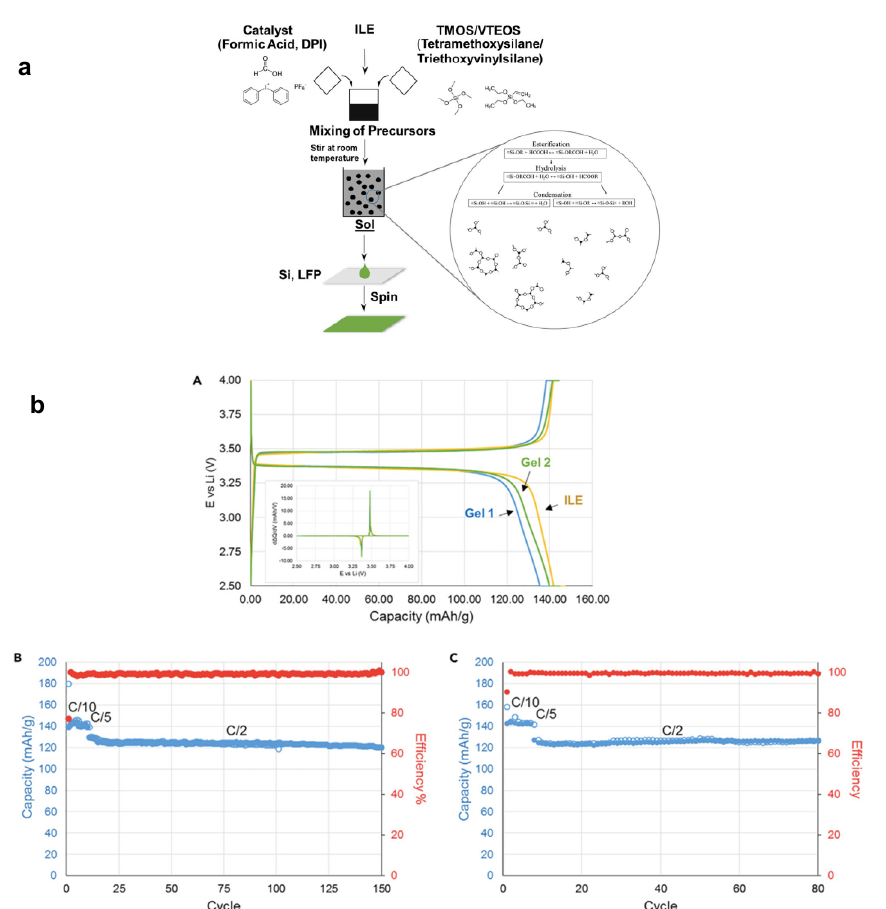
Figure 4. Schematic illustration of ( a ) spin-coating of TMOS/VTEOS IL-based gel electrolyte. ( b ) GV measurements of different electrolytes on LFP at C/10. Results are shown for gel 1 and gel 2, with the ionic liquid electrolyte (ILE) serving as a comparison (A). The inset shows the dQ/dV versus V curves extrapolated from the GV measurements. ( b ) Capacity variation with cycling for gel 1. Majority of the 150 cycles were at C/2 (B). Capacity variation with cycling for gel 2. Majority of the 80 cycles were at C/2 (C). Reprinted with permission from ref. [20].